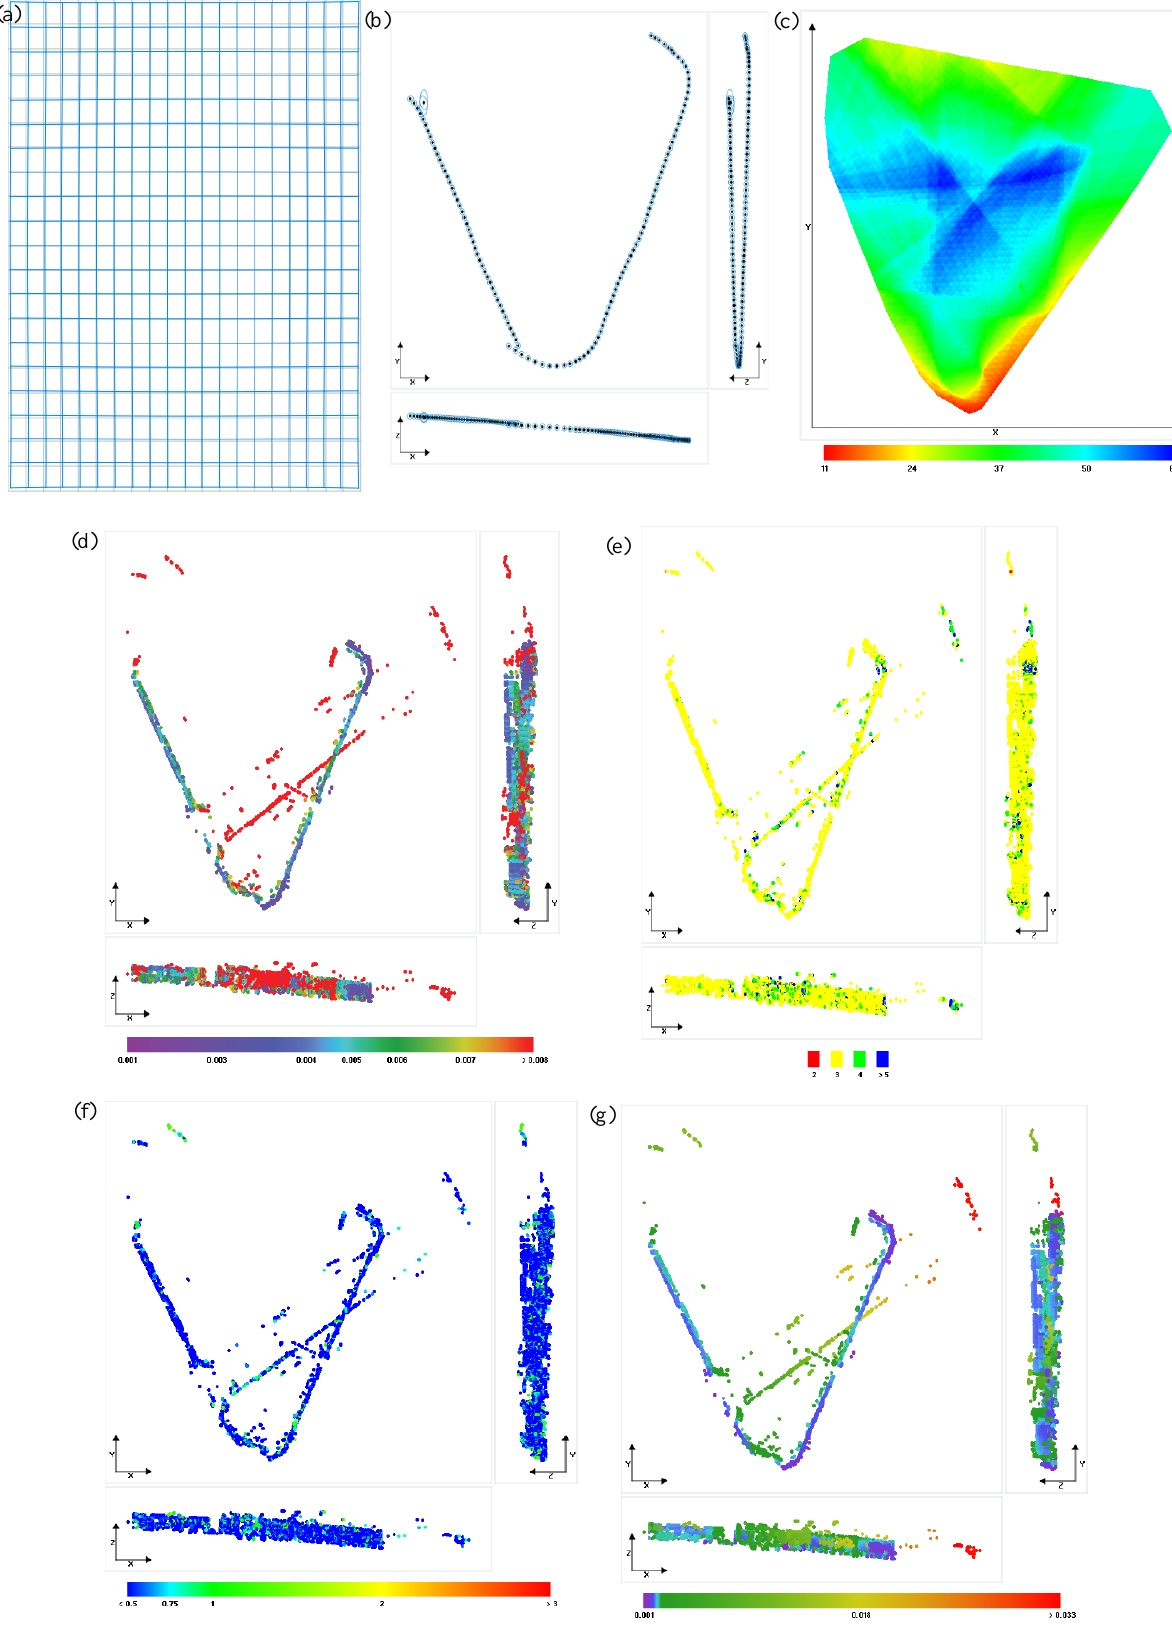
Figure 2a-g shows the aerotriangulation process report; (a) Distortion grid, (b)Photo position uncertainties, (c) Scene coverage, (d) Point uncertainties, (e) Number of photo observing tie points, (f) Reprojection error, and (g) Tie